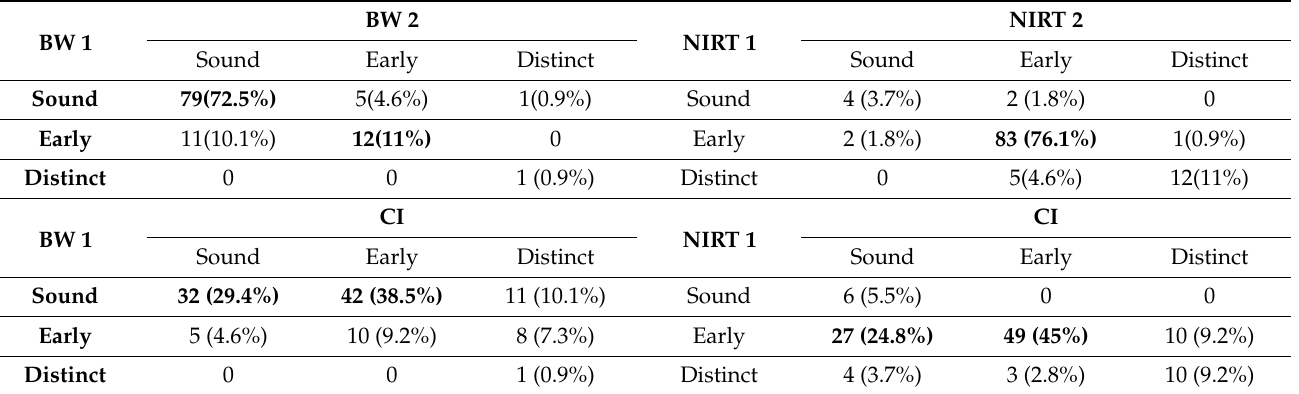
Table 5. Cross-tabulations for 109 occlusal surfaces with full data of experienced examiners (Clinical images (CI), near-infrared transillumination (NIRT), and bitewing radiographs (BW)). The agreement of both BW assessments is mostly on sound surfaces while NIRT assessments are on early caries. While most of the early lesions detected on clinical images (CI) were scored sound on BW, NIRT